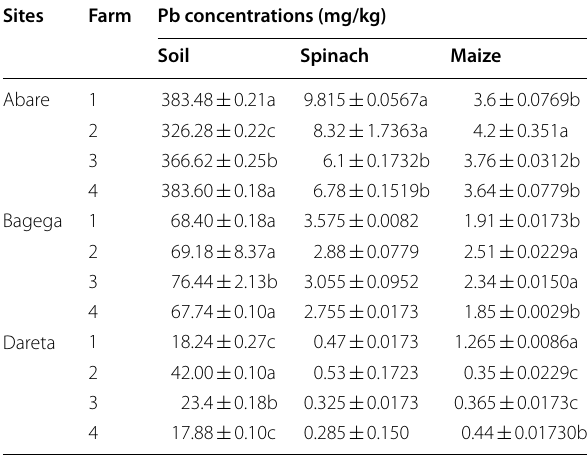
DPR, (2002) for soil: 85 mg/kg, EPA, (2004) for soil: 400 mg/kg, FAO/WHO (mg/kg) for crop: 35, FAO/WHO (mg/kg) for vegetable: 0.3; values are means errors (n 3); means with the same superscript letter within each column are = not significantly different at p <